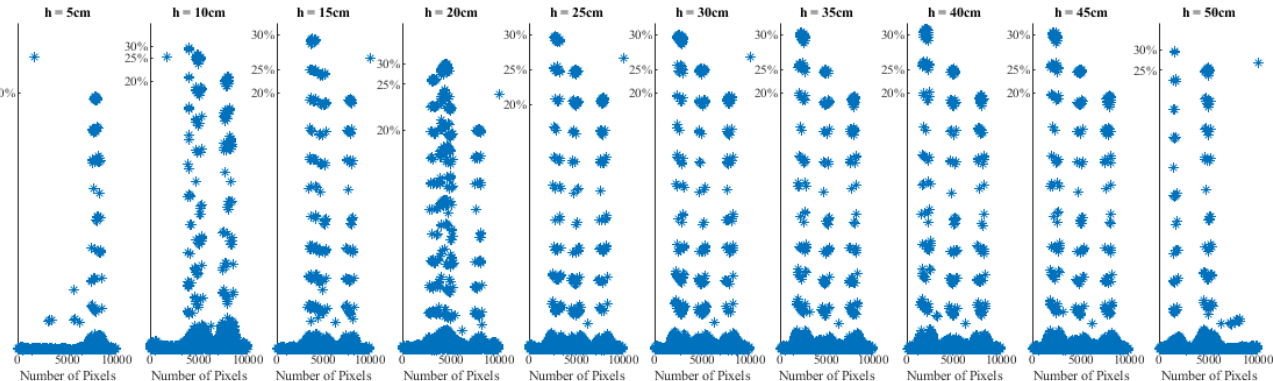
Figure 6. Scatter plot for regression machine learning.